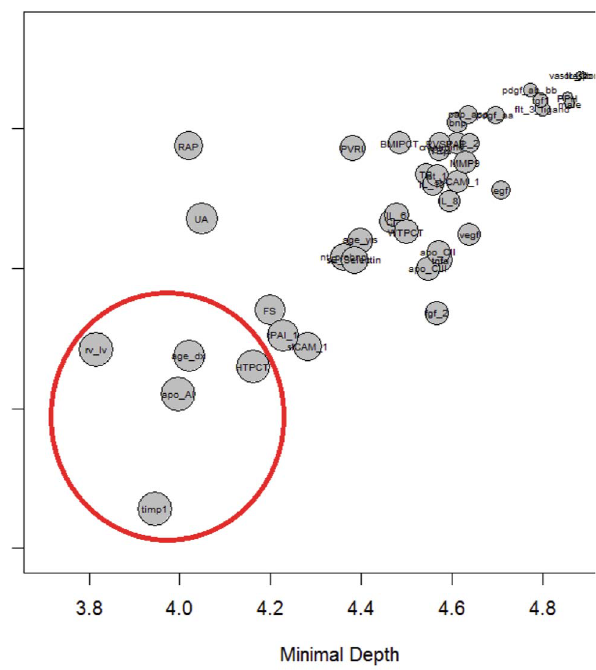
Figure 3. RSF maximal subtree results. Minimal depth versus distance of the second-closest maximal subtree. A circle’s diameter is proportional to the average number of maximal subtrees for a given variable. Predictive variables are displayed in the lower left corner with a larger radius. The top 5 predictors are indicated with a red circle.